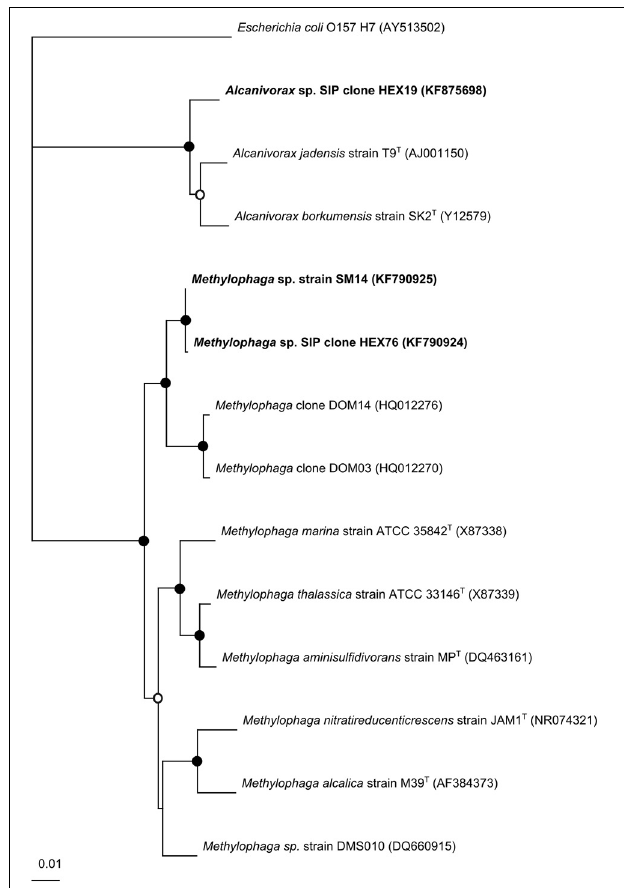
FIGURE 5 | Phylogenetic tree of SIP clones and the isolated strain from the North Carolina surface seawater sample. GenBank accession numbers are in parentheses. The tree was constructed using the neighbor-joining algorithm. Nodes with bootstrap support of at least 65% ( ) and 90% ( ) are marked (1000 replications). The scale bar indicates the difference of number of substitutions per